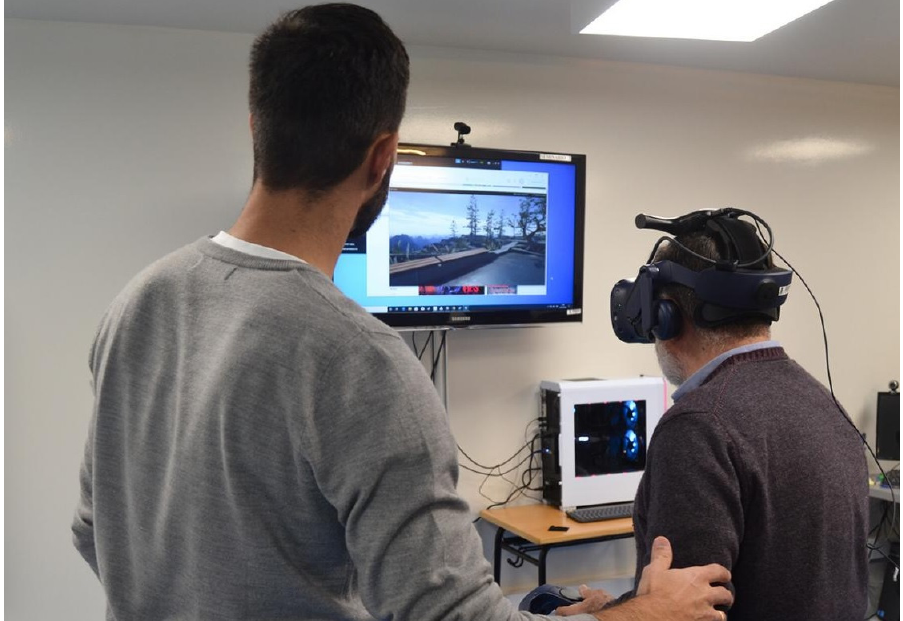
Figure 2. Participant during the introduction session (SteamVR Home) before the training session 1 placed in a mountain landscape.